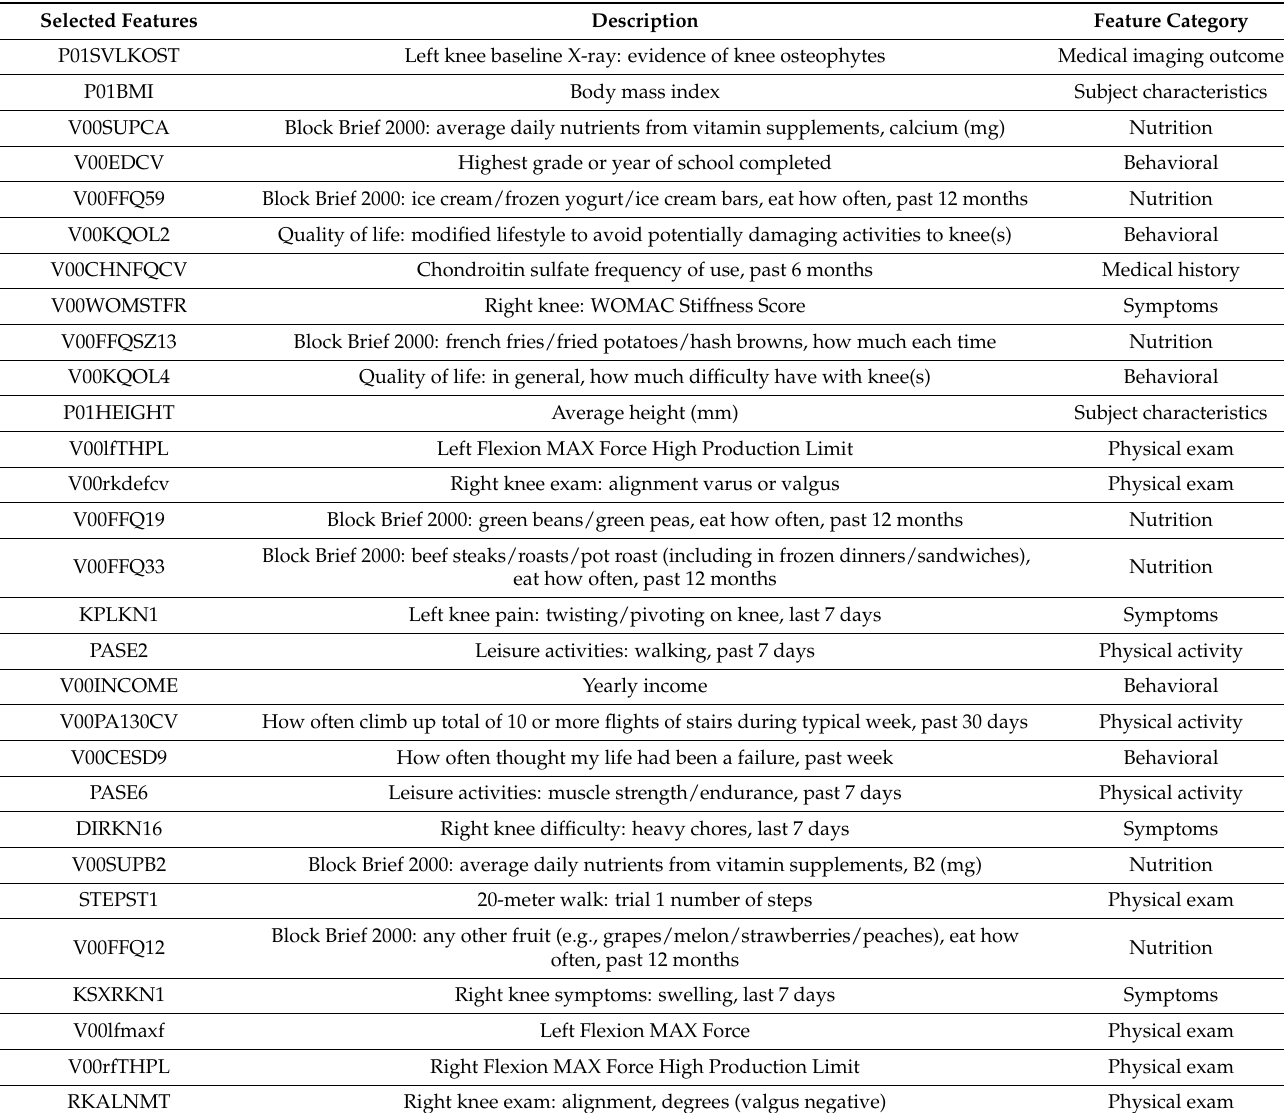
Table A1. Selected features that led to the best overall KOA prediction performance in our study. The features have been ranked according to their impact on the classification result as calculated by SHapley Additive exPlanations (SHAP). Selected